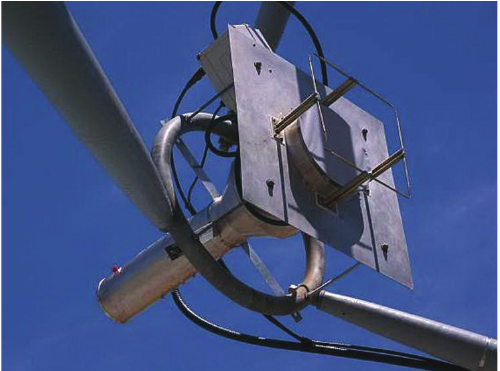
Figure 1: Doug McArthur’s feed for 70/23 cm bands.